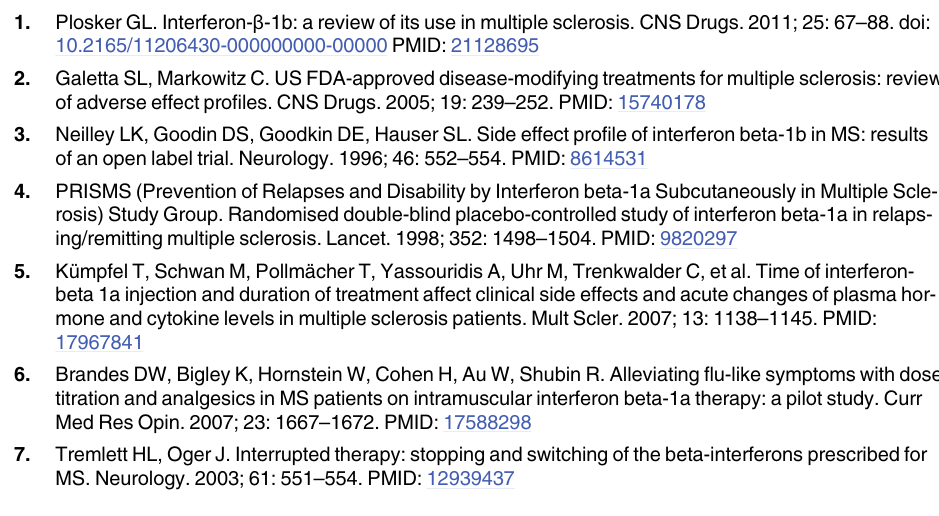
S1 Table. Self-reported symptoms scoring as reported in patient diary. S2 Table. Results of the multivariable repeated-measures logistic regression used to esti- mate the probability of having FLS after each weekly